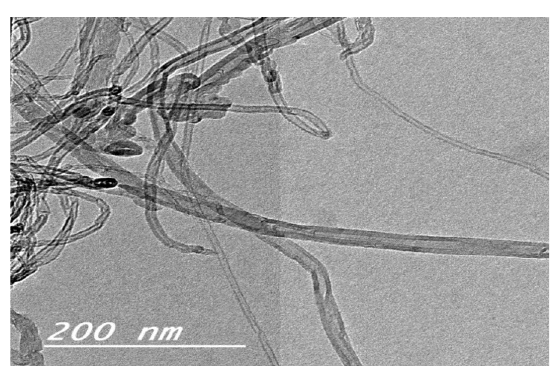
Fig. 6 CNTs transmission electron microscope micrograph